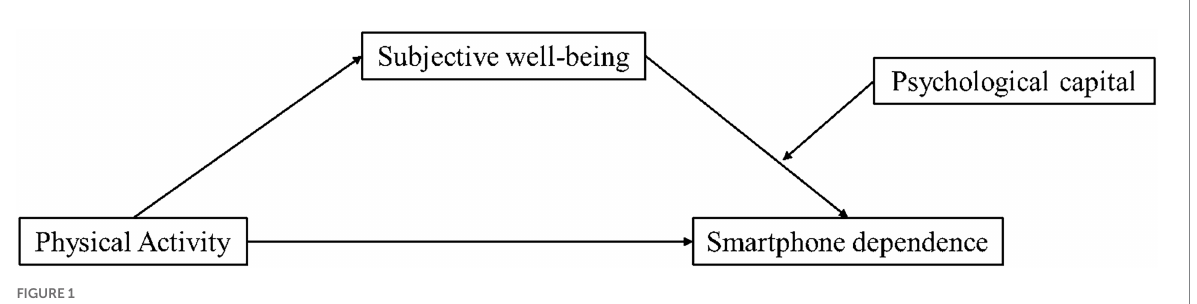
FIGURE 1 Theoretical model